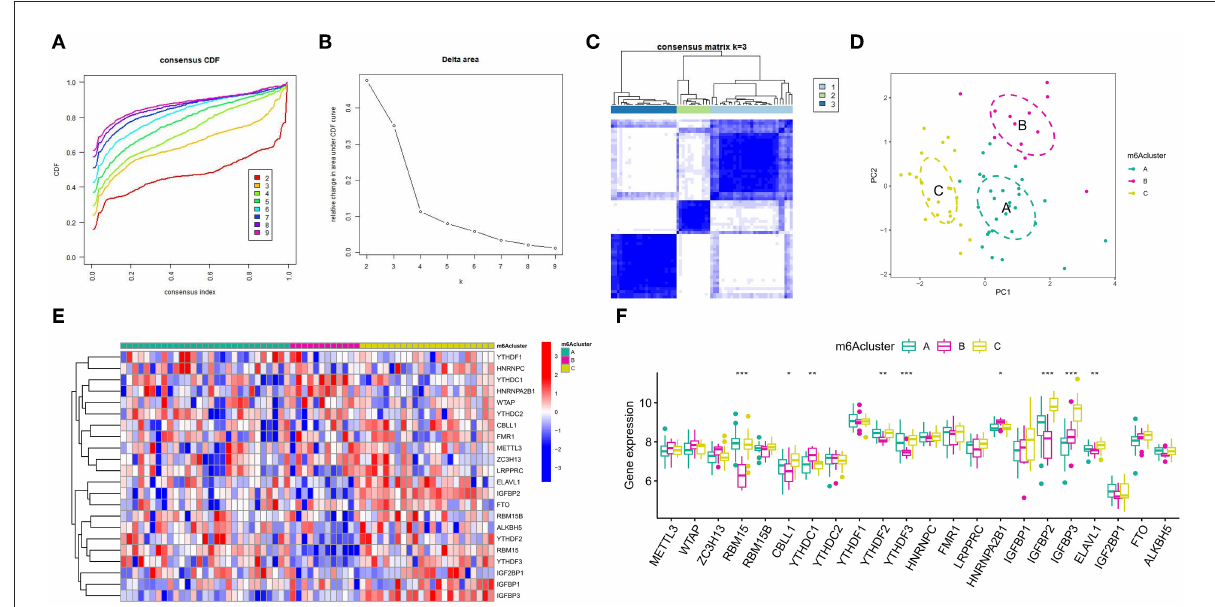
FIGURE6 Unsupervised clustering of 22 distinct m6A modulators. Three different m6A modification patterns in the intracranial aneurysm. (A) Cumulative distribution function (CDF) for consensus clustering for k = 2–9. (B) Relative change in the area under the CDF curve for k = 2–9. (C) Matrix of co-occurrence percentages for cerebral aneurysm samples visualized as a heatmap. (D) Principal component analysis was used to analyze the transcriptome profiles of three m6A subtypes. A striking divergence in the transcriptome across the various modification patterns can be seen. (E) Unsupervised clustering of 22 m6A regulators in the three modification patterns. (F) State of expression of 22 distinct m6A modulators in each of the three m6A subsets. The symbols * , ** , and *** indicates the value of p < 0.05, p < 0.01, and p < 0.001